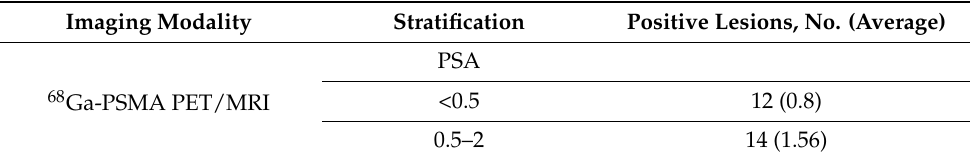
Table 4. Study of the differences in the number of lesions detected by 68 Ga-PSMA and 68 Ga-DOTA- RM2 and clinical